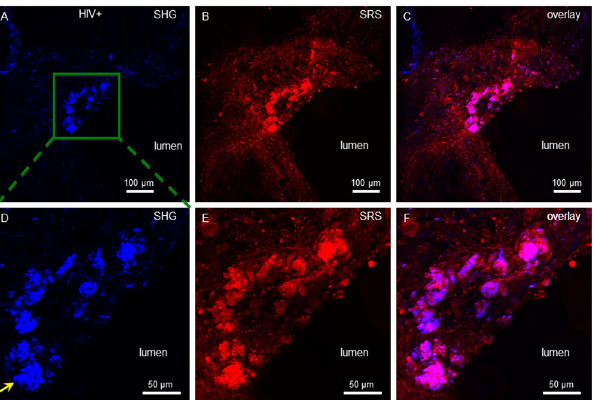
Fig 5. A lipid rich HIV + coronary artery plaque with aggregated cuboidal CCs. SHG (A), SRS (B) and overlay (C) images of a lipid rich plaque. Panels (D), (E) and (F) show the same plaque at higher magnification, corresponding to the area enclosed by the green box in (A). SRS images were recorded at 2845 cm -1 . Magenta indicates regions of high overlap in the overlay images. Vessel lumen of the left descending artery and magnification scales are indicated, and yellow arrow in panel D denotes cuboidal feature shown in higher detail in Fig 7D.